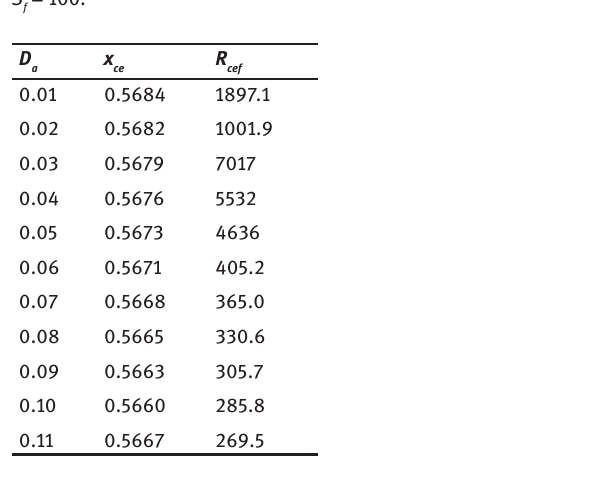
) for F =2, V =1 and a 1 r